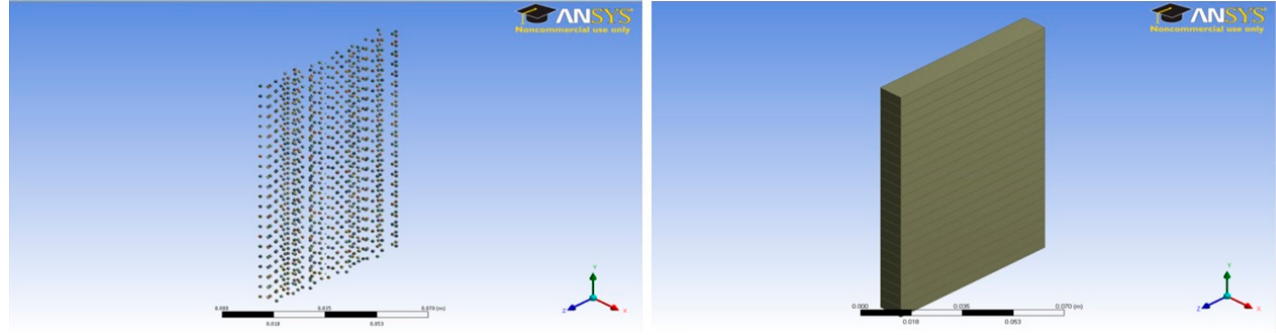
Polymers 2022 , 14 , x FOR PEER REVIEW Figure 6. Three percent fiber sample model (11 × 7 × 1 cm) and concrete slab. Figure 6. Three percent fiber sample model (11 × 7 × 1 cm) and concrete slab.